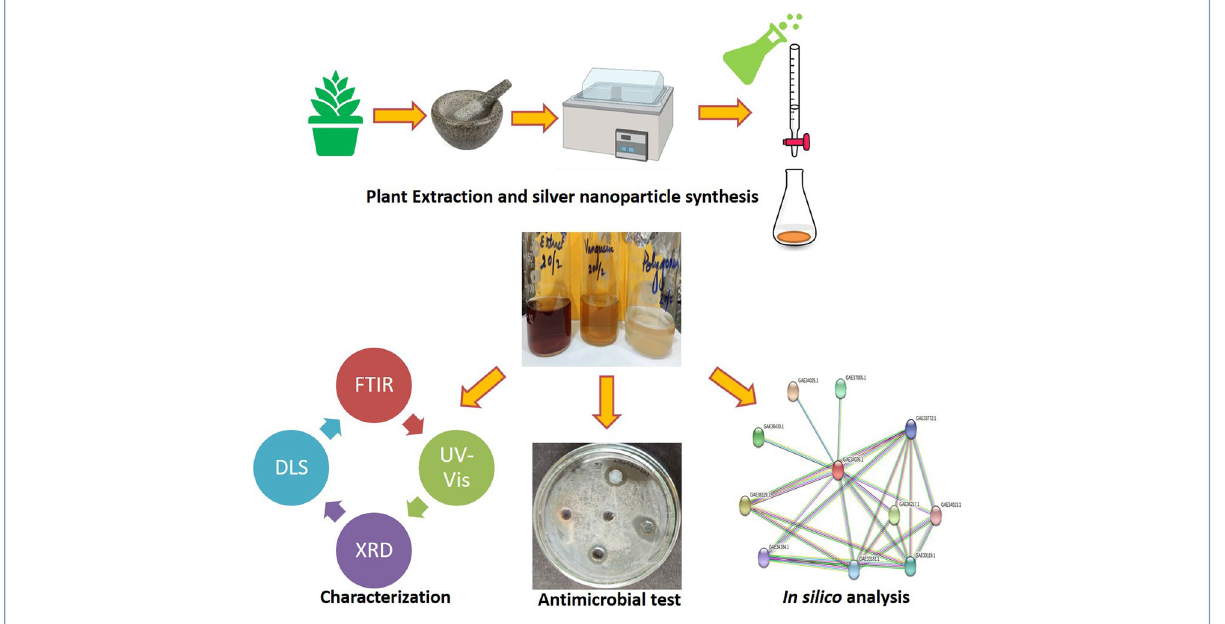
study to analyse the mechanism of antibacterial